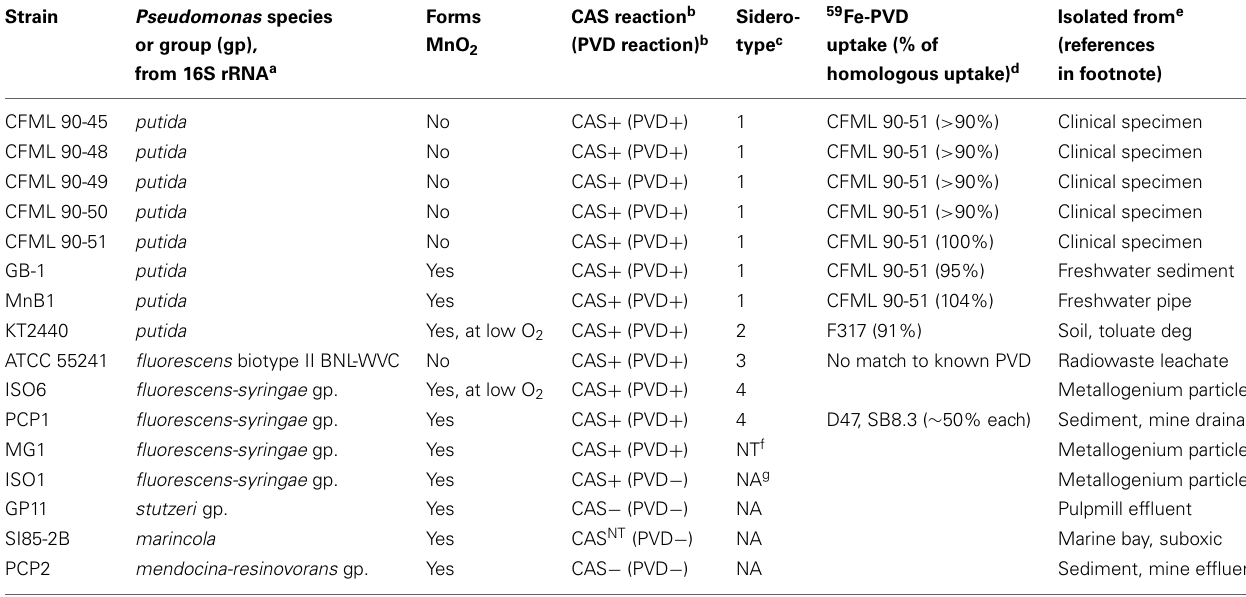
Table 2 | Properties of various Pseudomonas sp. strains